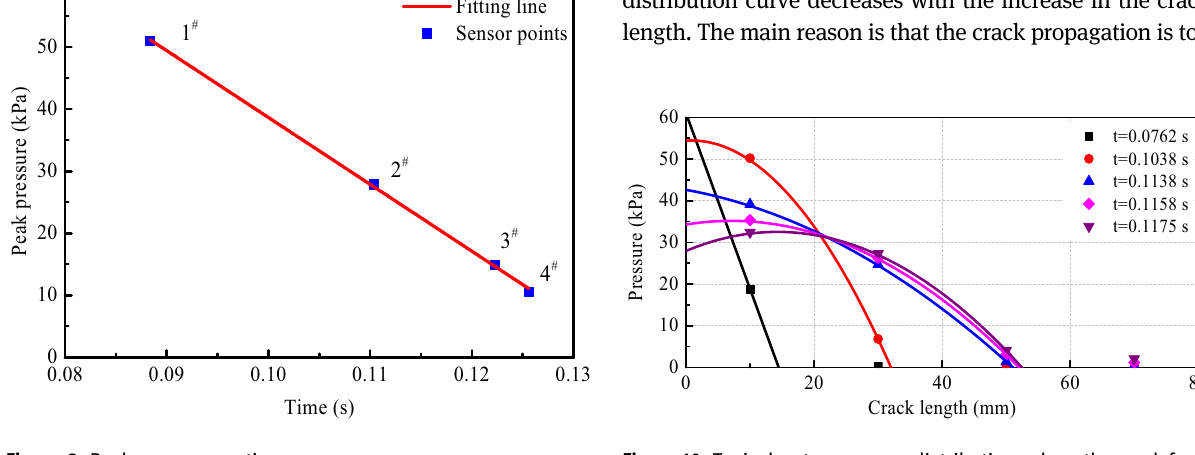
Figure 8: Peak pressure vs time.